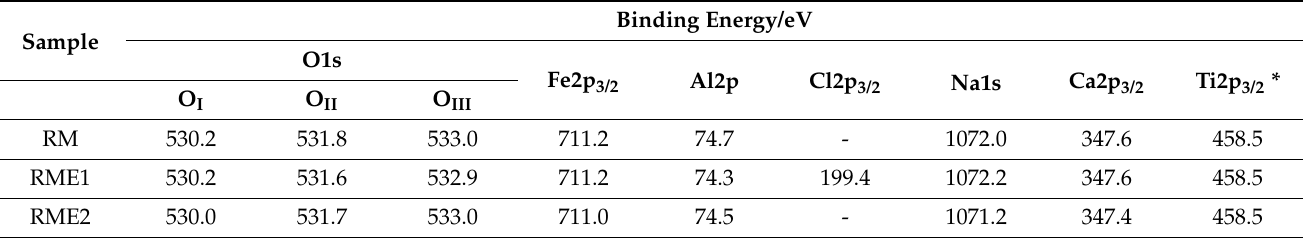
Table 3. Binding energies of electrons coming from different core levels for the RM and RME samples.